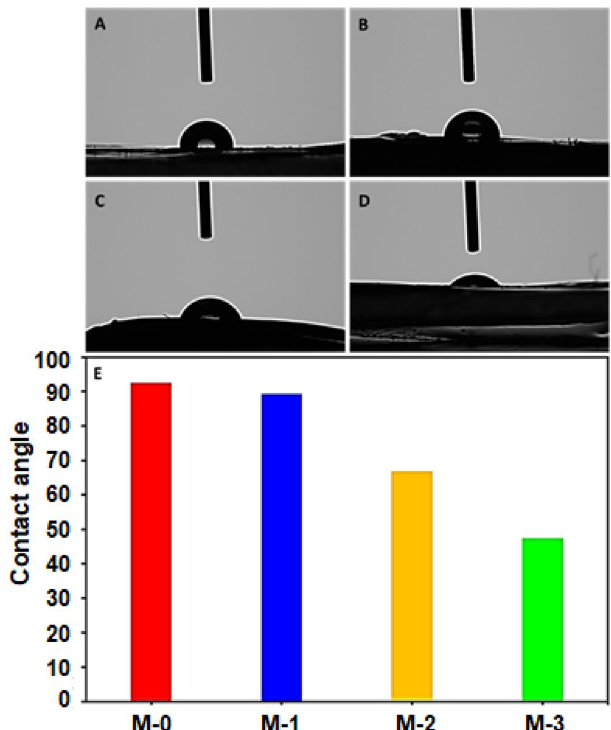
Figure 7. Water contact angle on the surface of the different membranes ( A ) M-0 , ( B ) M-1 , ( C ) M-2 and ( D ) M-3